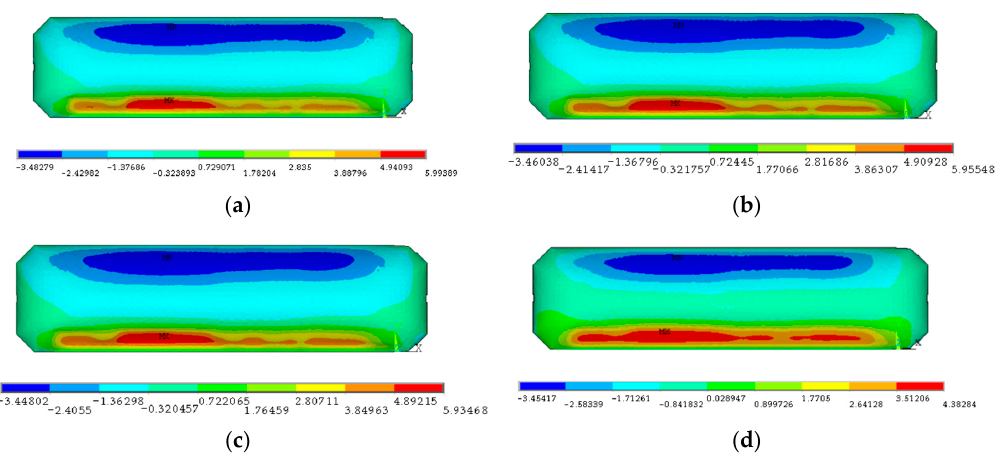
Figure 9. Cloud chart of y -component membrane surface displacement (unit: m): ( a ) μ = 0.2; ( b ) μ = 0.44; ( c ) μ = 0.68; and ( d ) μ = ∞ *.